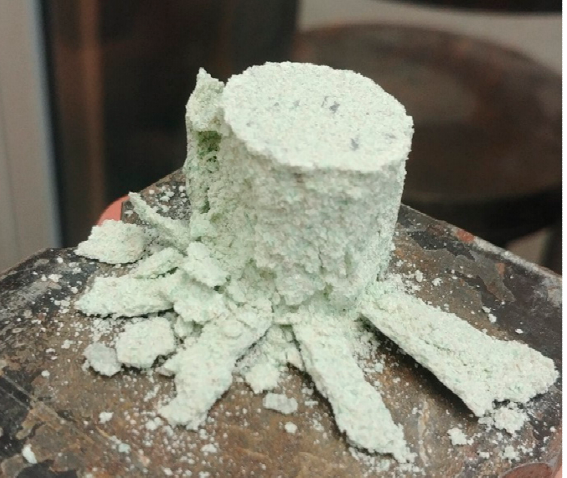
Figure 3. Scheme for the preparation of silica–lime samples involving packaging glass.